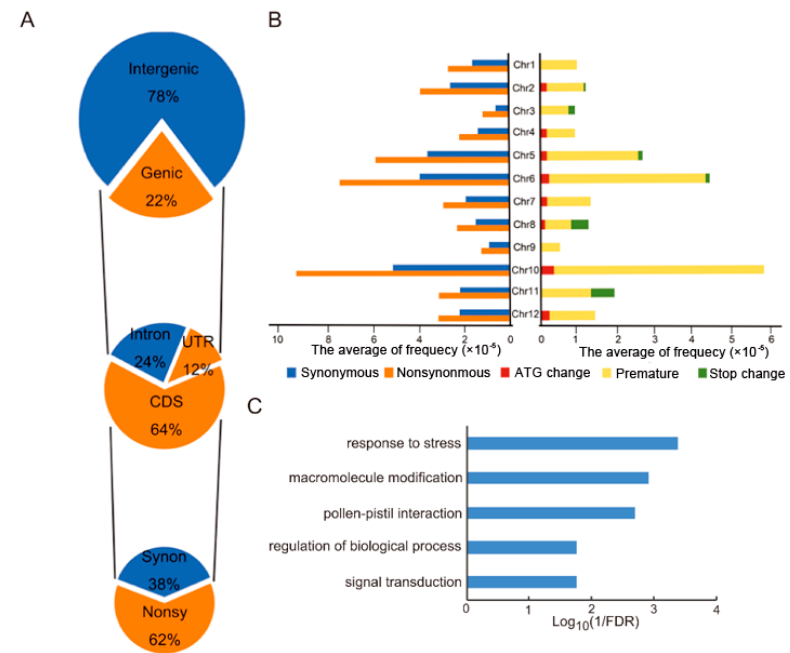
Figure 3. Distribution of SNPs within 100-kb windows across each chromosome. Different rice chromosomes (Chr-12) are indicated in different colors. The X-axis represents the length of each chromosome divided by 0.1 Mb. The Y-axis indicates the number of SNPs. Black solid ellipse represents the centromere. Red frames indicate the domestication-related regions identified in japonica rice [28].